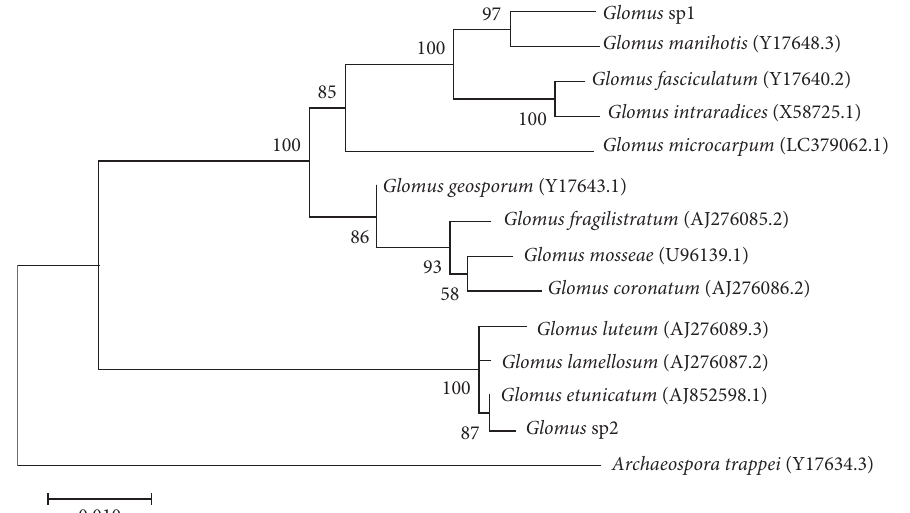
Figure 2: Phylogenetic tree of partial 18S (SSU), 5.8S (ITS), and partial 28S (LSU) rDNA sequences of 14 Glomeromycota representatives. Neighbor-joining (NJ) analysis including Archaeospora trappei as outgroup. Bootstrap values are given for each branch (BV > 50). Scale bar indicates the number of substitutions per site.